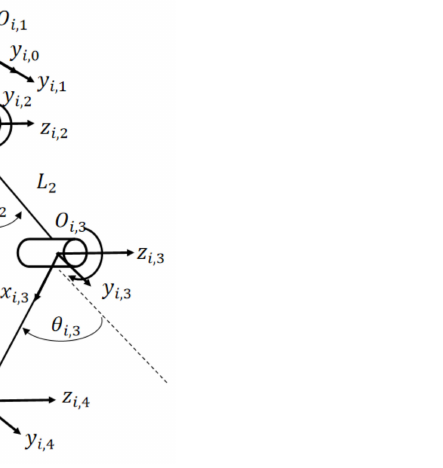
Figure 2. The single-leg model of the quadruped robot is modeled by the D-H